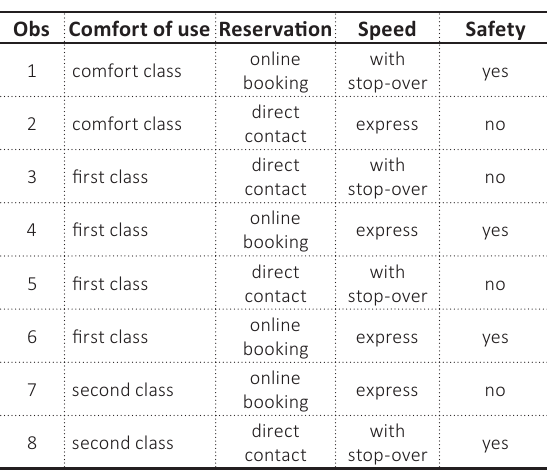
Table 2. Optimal